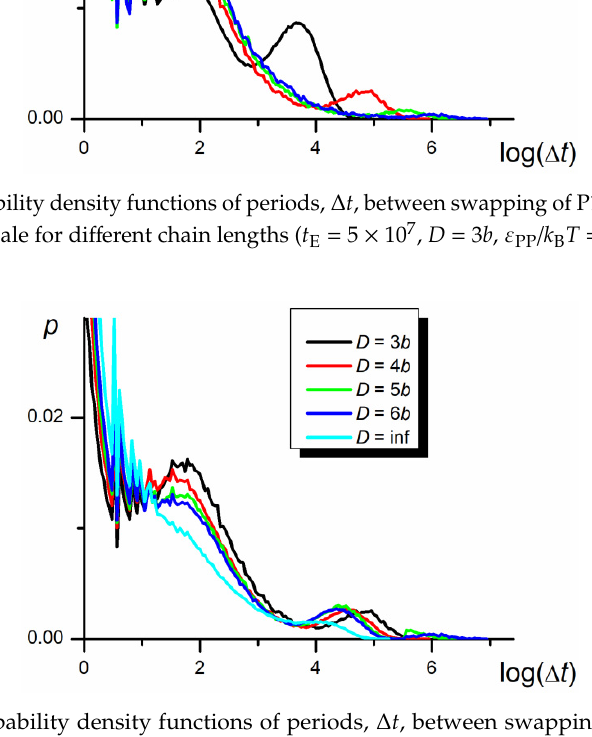
Figure 10. The probability density functions of periods, Δ t, between swapping of P1 and P2 mass centers in the logarithmic scale for different nanopore width ( N = 100, ε PP / k B T = 0 and − 1 for P1 and P2, respectively).